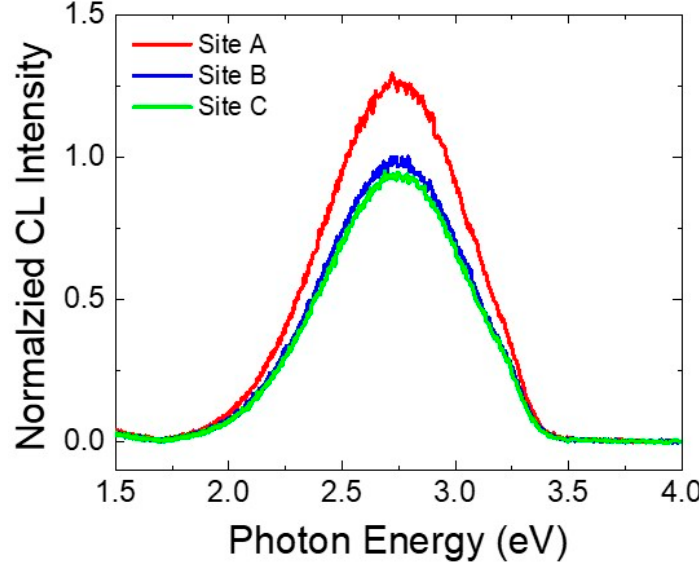
ff erent sites denoted as A–C in Figure